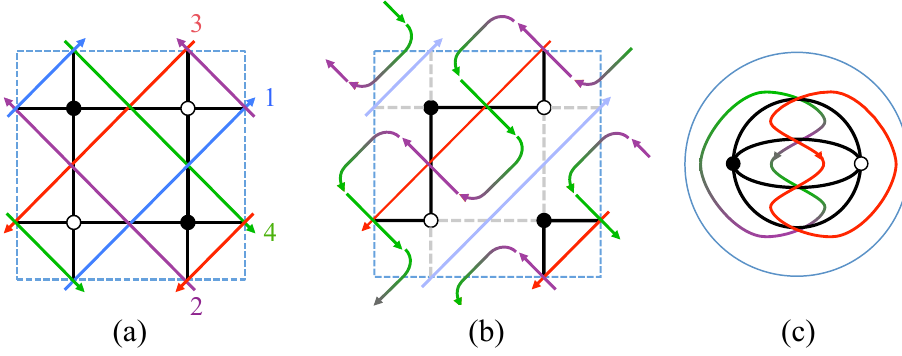
Figure 13. Backreaction in the mirror of F 0 . The instanton wraps the blue 1-cycle, which corresponds to face 1 of the original dimer. The (cid:12)nal result is the mirror of the conifold.